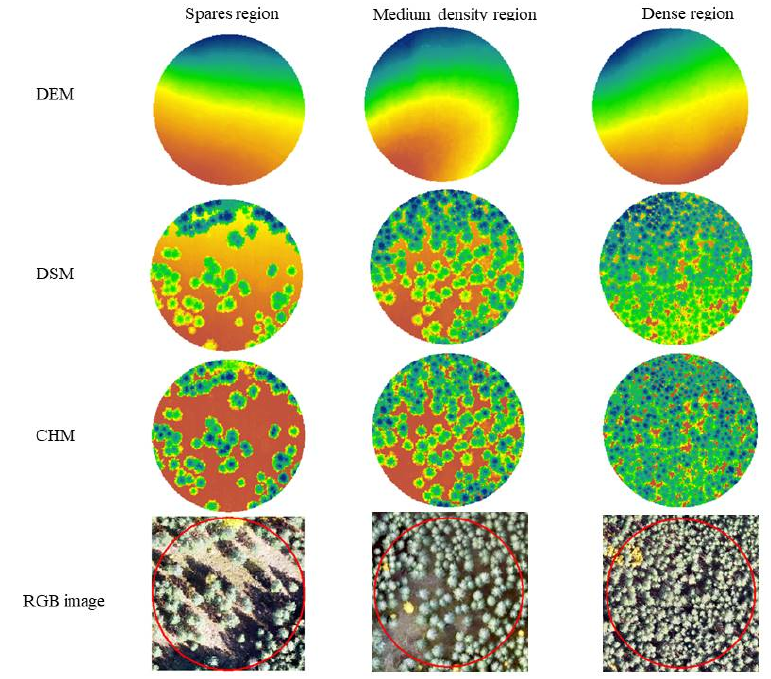
Figure 2. Location of the study area. ( a – e ) show the location of the study area in China. Our research mainly focuses on the region that UAV_LiDAR covered ( b ); ( c ) denotes the location relationship of the study area (marked by yellow polygon) and Hulunbuir City. ( d , e ) present the location relationship of study area and Ewenke Banner. The LiDAR point data and their products such as CHM (canopy height model), DSM (digital surface model) and DEM (digital elevation model) are also presented below.